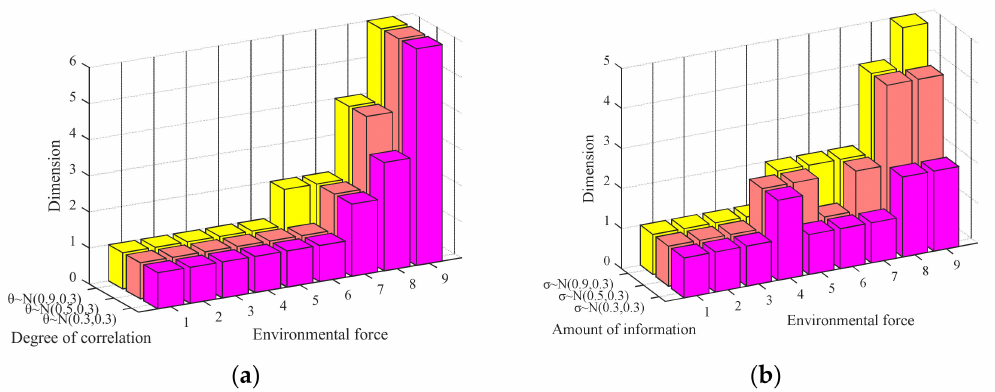
Figure 28. Combination analysis of environmental forces, correlation and the amount of information contained in subtopics. ( a ) The relationship among dimension, environmental forces and correlation. ( b ) The relationship among dimension, environmental forces and amount of